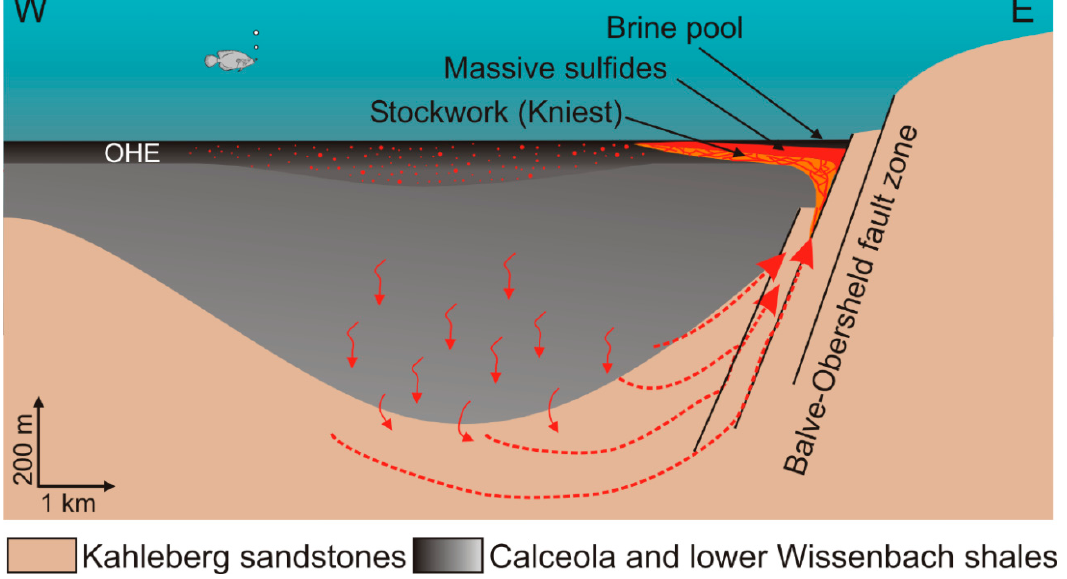
Figure 2. Proposed paleogeographic model for the Goslar Basin at the massive sulfide deposition time (middle Eifelian). Red arrows indicate pathways of basinal fluids. OHE; Ore horizon equivalent. Modified from Hannak [41] and S á ez et al.